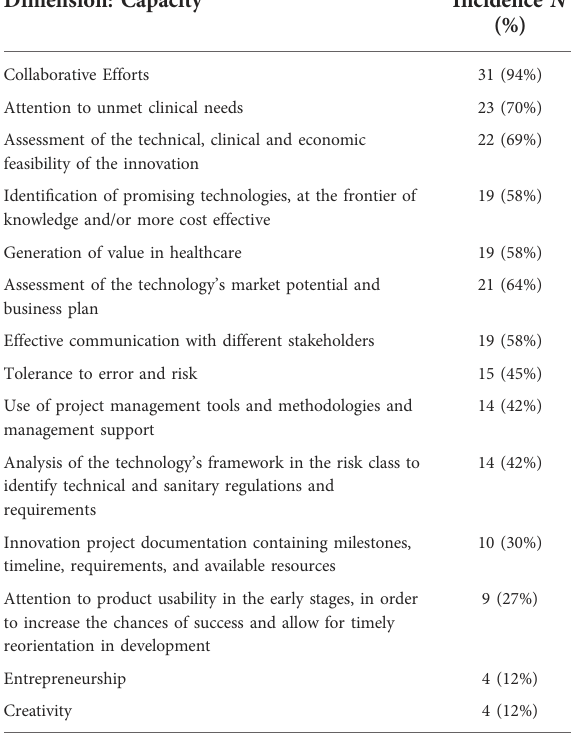
TABLE 3 Incidence of themes related to the attributes of translational research grouped by the Institutional dimension. Dimension: Institutional or